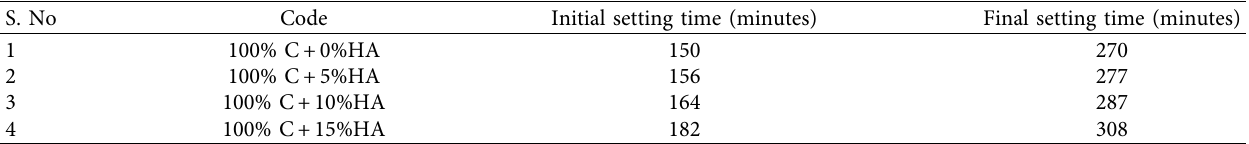
Table 8: Concrete paste setting time containing hybrid CHA&SCBA ash.